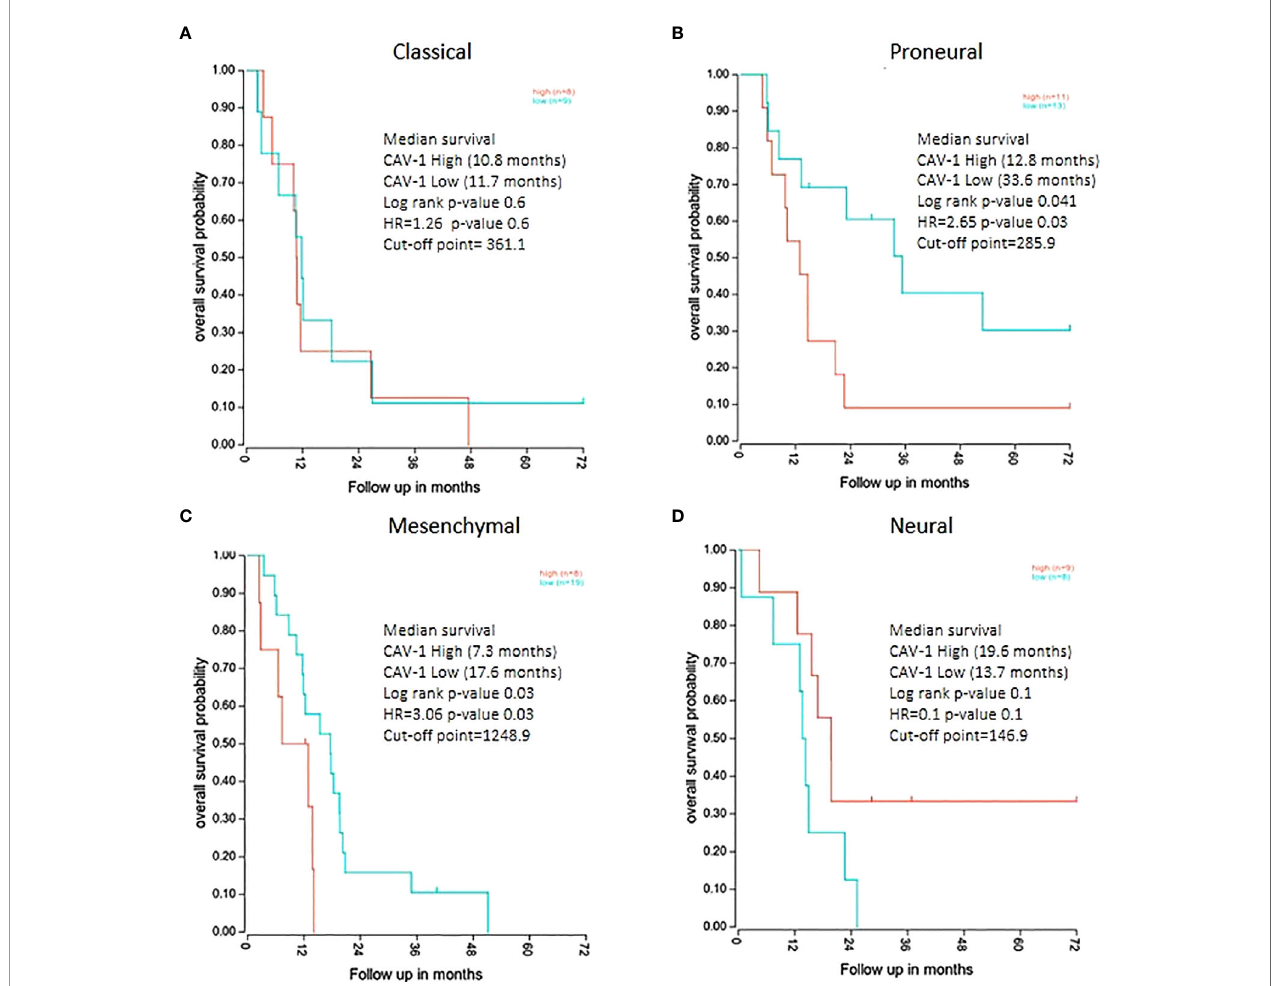
FIGURE 5 | Kaplan Meier survival analysis of GB patients divided by molecular subtype groups with survival categorised by high and low tumour expression levels of Cav-1: (A) Classical (cut-point value=361.1), (B) Proneural (cut-point value=285.9), (C) Mesenchymal (cut-point value=1248.9), (D) Neural (cut-point value=146.9). For each curve the log rank p-value, median survival in months and Hazard Ratio value (HR) is reported. The plots show the cut-point (expression level) that corresponds to the most optimal (statistically signi fi cant) discrimination point with respect to outcome (i.e.